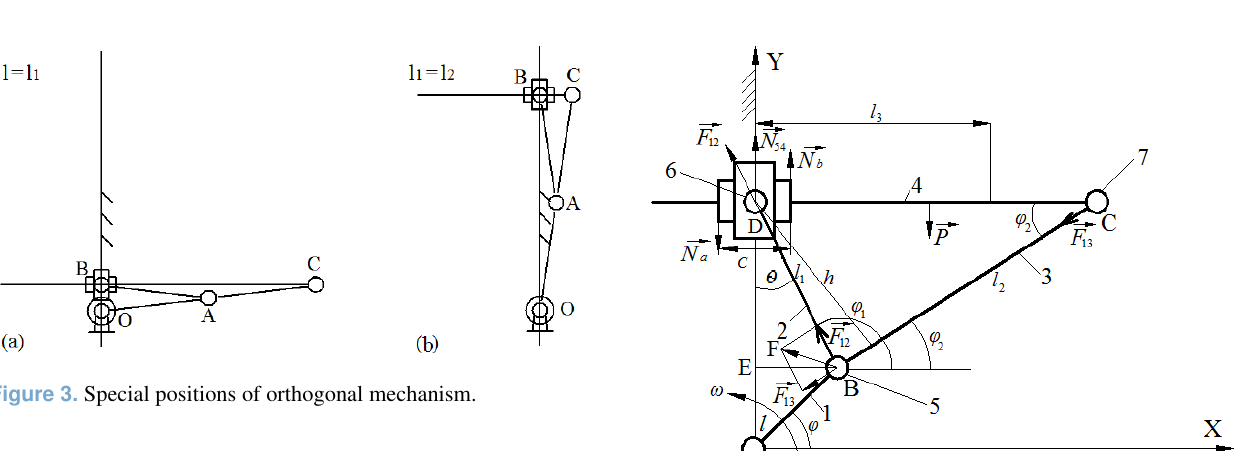
Figure 2. Structural model of the orthogonal mechanism and the graphs of variance projection components of analogues of velocity and acceleration of the operating point C in the different ratios of the lengths of links l : l 1 : l 2 .